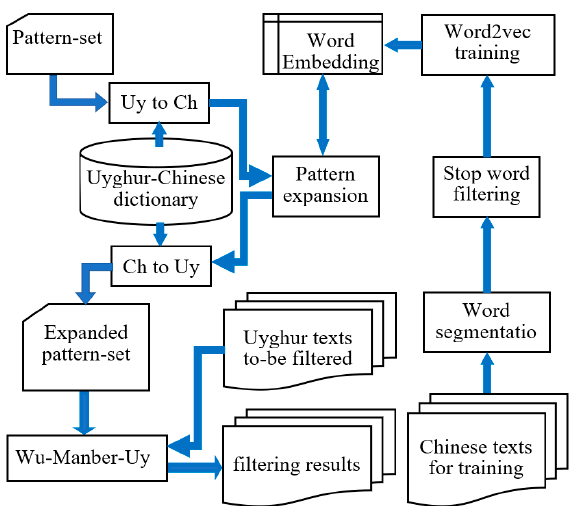
Figure 10. Flowchart of Uyghur text filtering process.